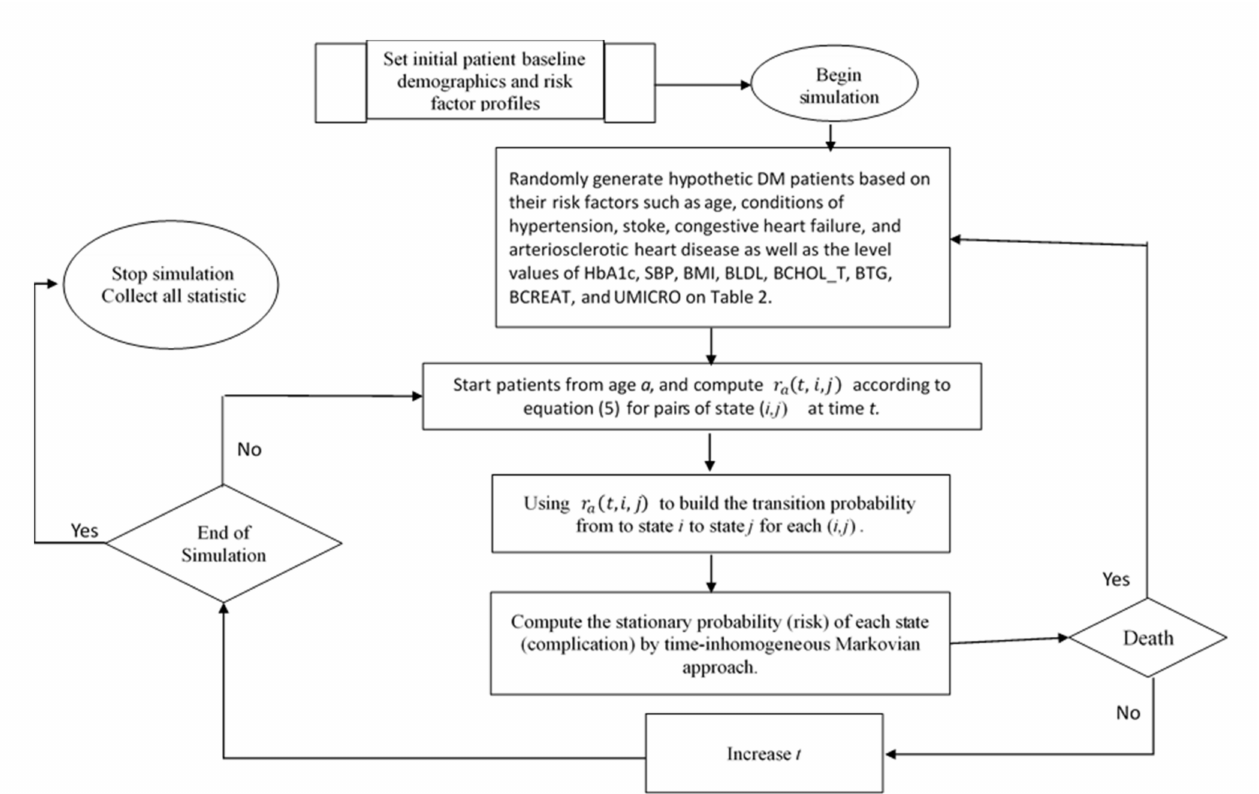
Figure 4. Flowchart of nonhomogeneous Markovian simulation for diabetes mellitus